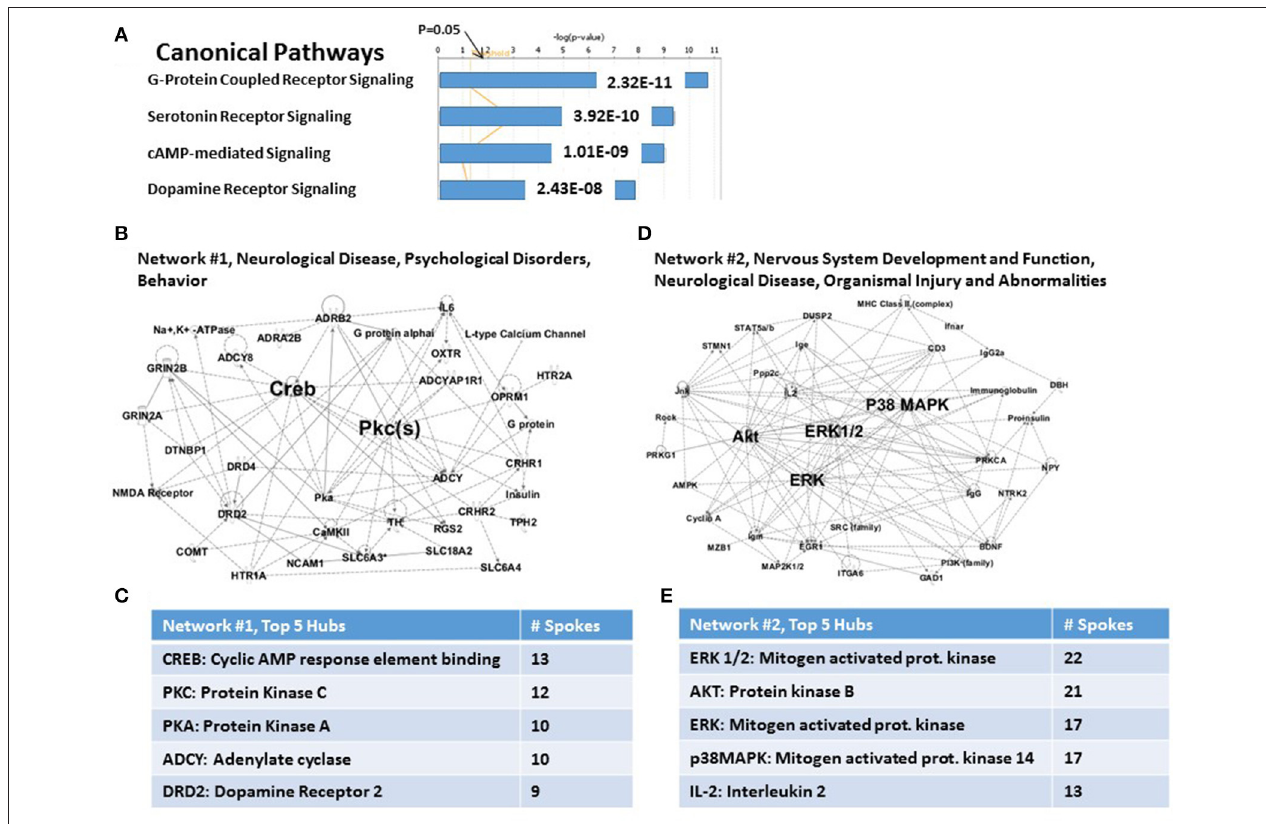
FIGURE 1 | Functional relationships among 83 candidate PTSD genes. (A) Top canonical pathways. Two top signaling pathways are G-Protein Coupled Receptor and Serotonin Receptor signaling. (B) Associated network Function #1. CREB and PKC are top hubs in this network. (C) Inset : Network #1, top 5 hubs. (D) Associated network Function #2. ERK1/2, AKT, ERK, and p38MAPK are top hubs in this network. (E) Inset : Network #2, top 5